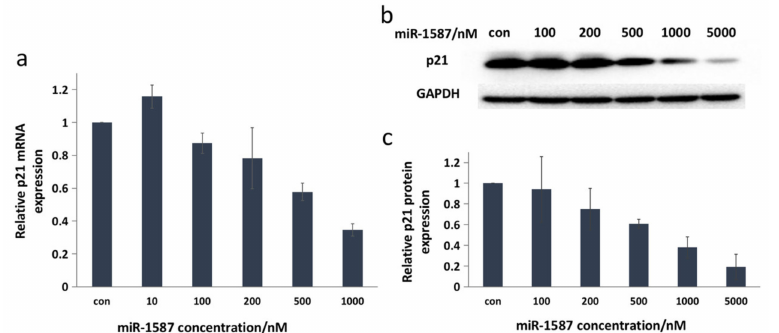
Figure 5. P21 was downregulated. ( a ) q-RT-PCR results for p21, with beta-actin as a control. ( b ) Western blot of p21, with GAPDH as a control. ( c ) Histogram of p21 protein levels at differ- ent miR-1587 concentrations. Data were obtained through two independent sets of HeLa cells and the regulation results of each set were applied for analysis.